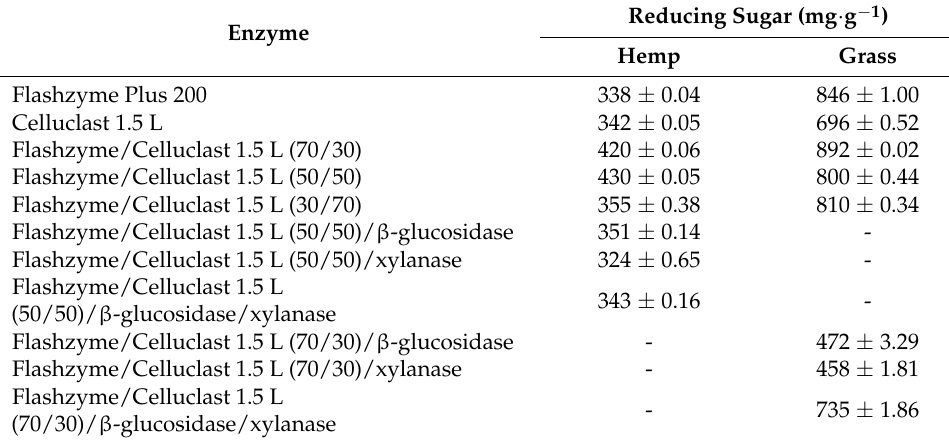
Table 3. Content of reducing sugars after the enzymatic